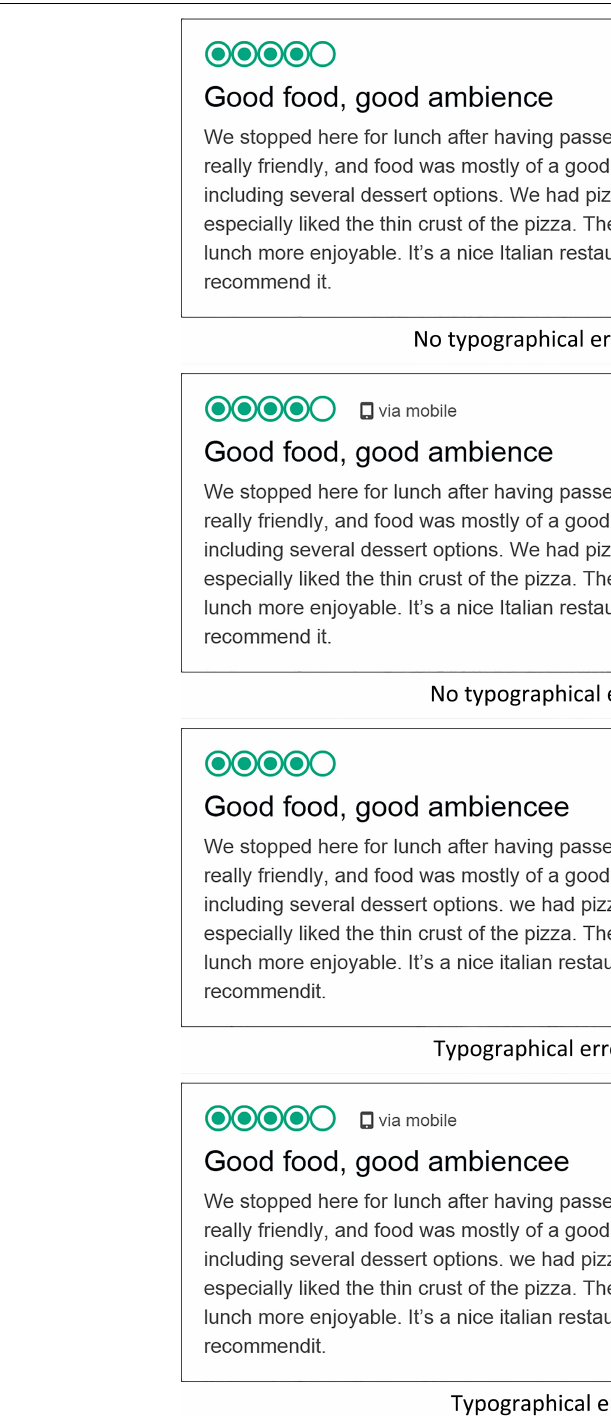
written by other consumers in general (1 = strongly disagree vs. 7 = strongly agree): “Before visiting restaurants, I